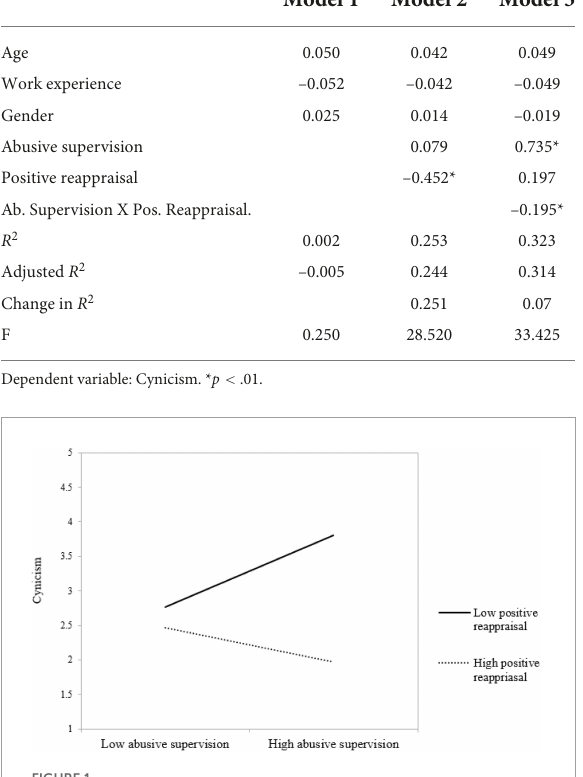
FIGURE1 Moderating effect of positive reappraisal on the relationship between abusive supervision and cynicism.